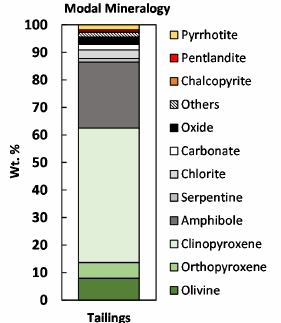
Figure 8. Modal mineralogy of the